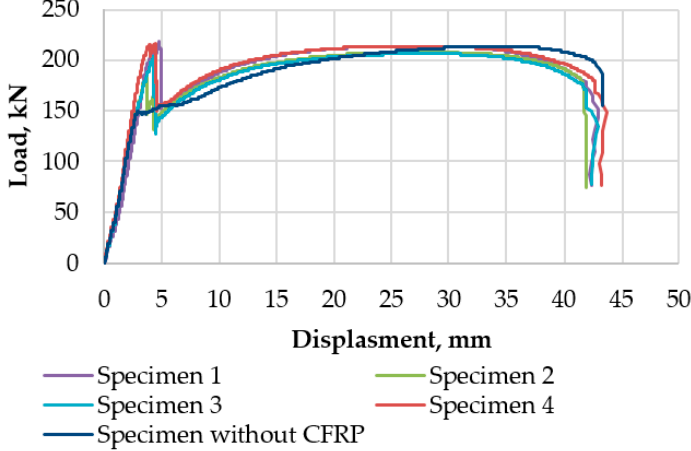
Figure 10. Displacement-load dependencies for strengthened specimens.